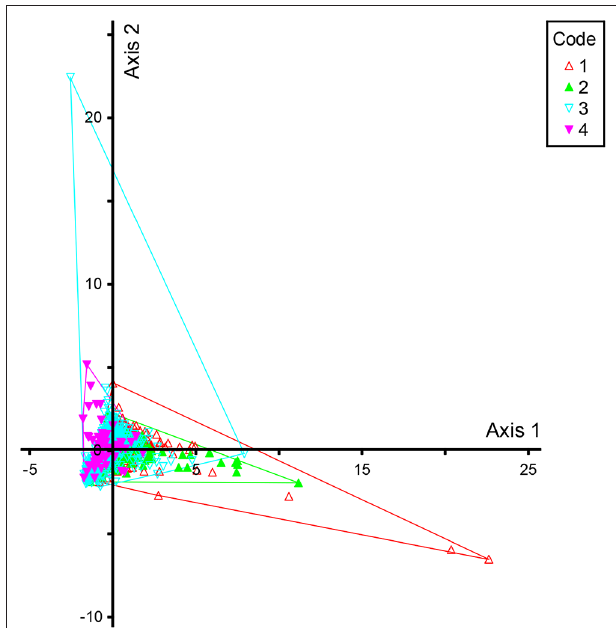
FIGURE 3 | Principal Components Analysis for channeled valley-bottom (VB-C) and unchannelled valley-bottom (VB-U) wetlands based on area, perimeter, shape, and fractal dimension. Convex hull codes: 1, VB-C (Drakenstein); 2, VB-C (CoCT); 3, VB-U (Drakenstein); 4, VB-U (CoCT).